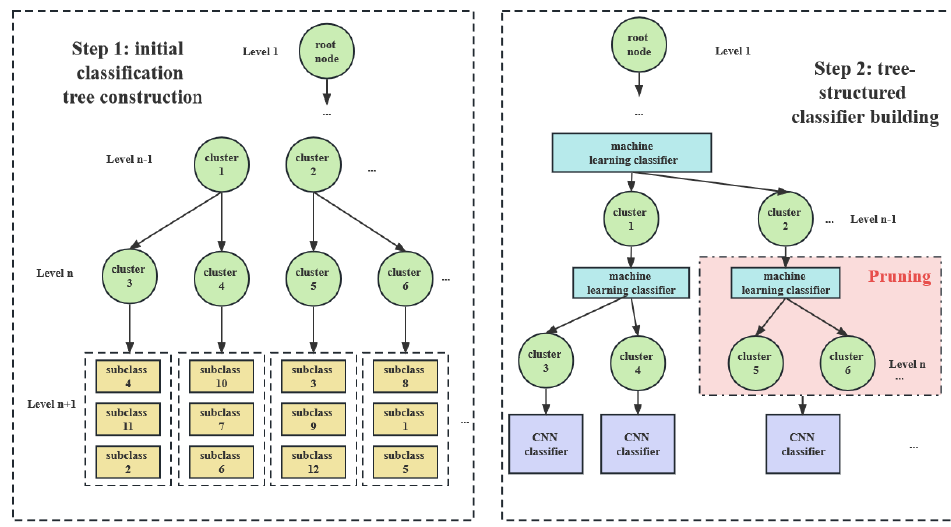
Figure 3. The process of constructing a tree-structured